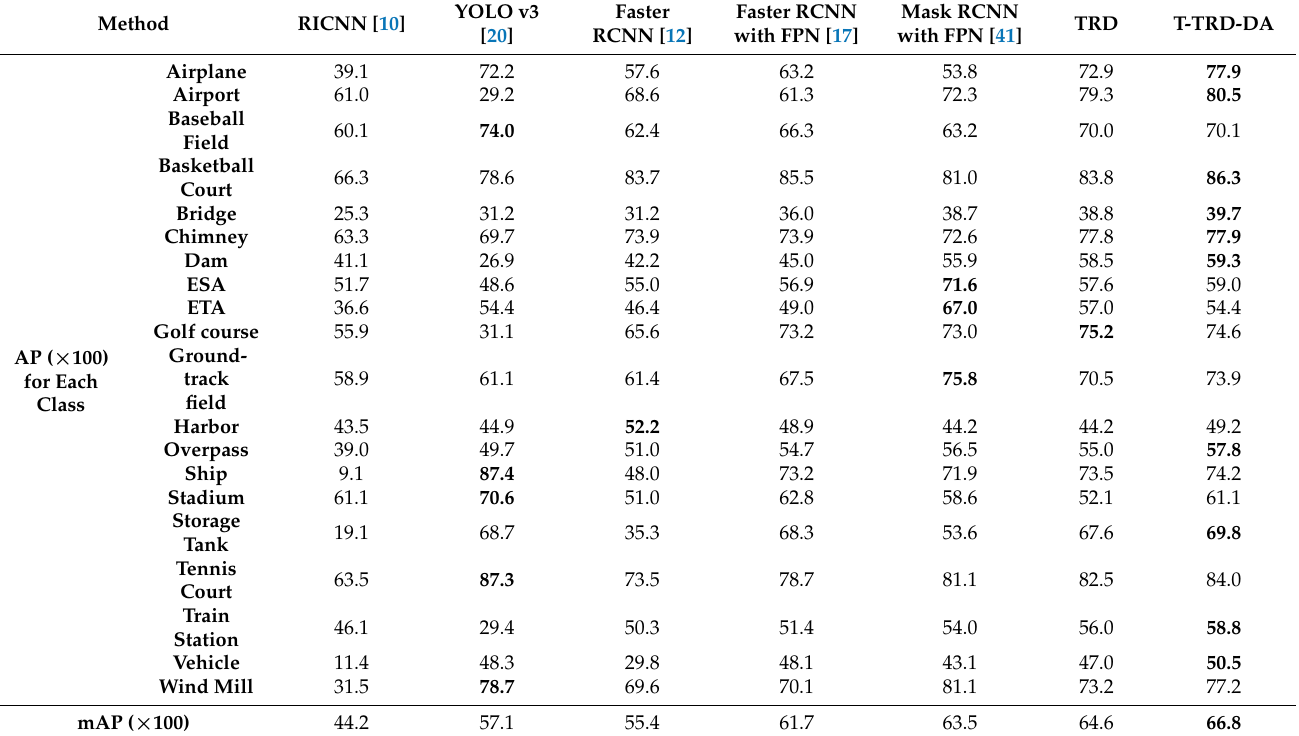
Table 3. Comparison results of the proposed methods and baseline methods on the DIOR data